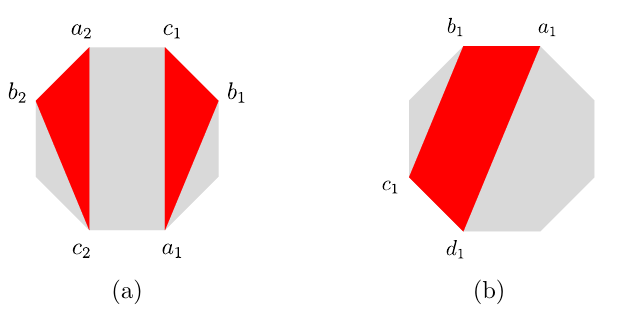
Figure 2 . Labels for the k = 2 generalised triangles: (a) T ( n )